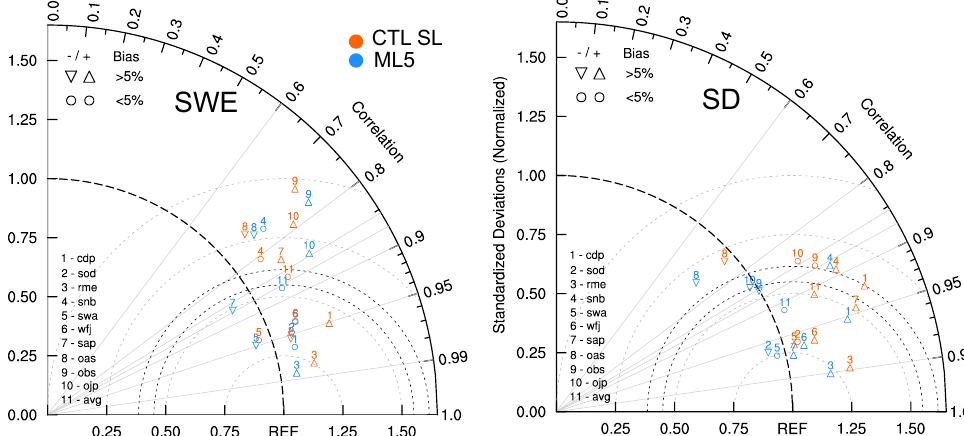
Figure 15. Taylor diagram of Snow Water Equivalent (SWE, left ) and snow depth (SD, right ) for offline simulations using the single-layer (CTL SL, red) and multi-layer (ML5, blue) snow schemes over the ESM-SnowMIP sites; see Section 4.2 for details on the ESM-SnowMIP